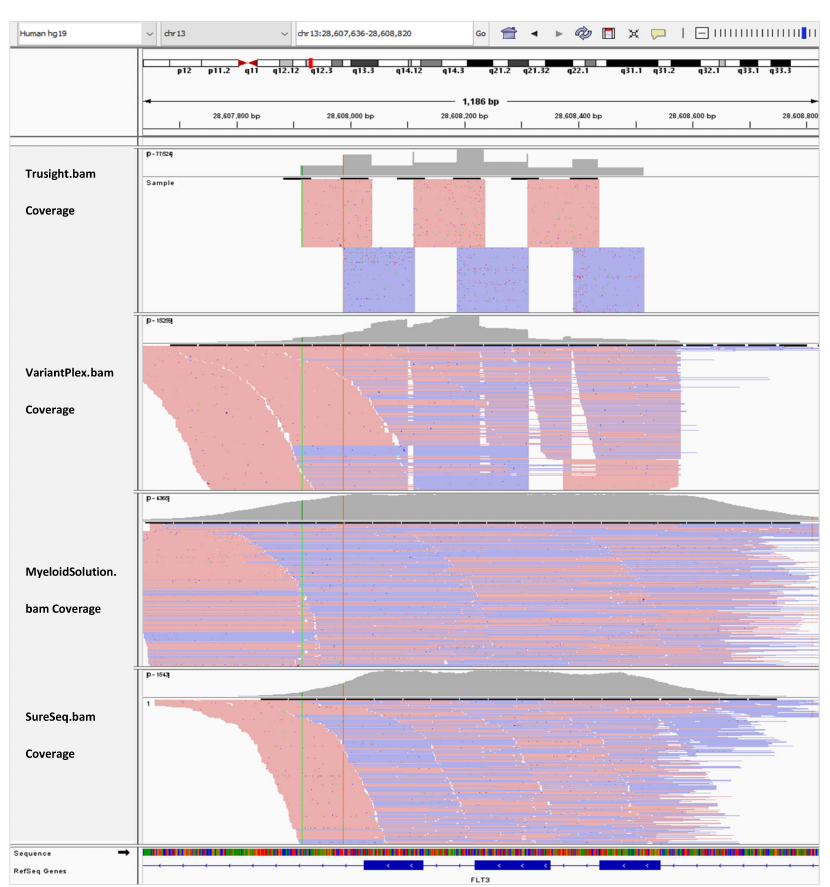
Figure 3. IGV tracks of FLT3 exon